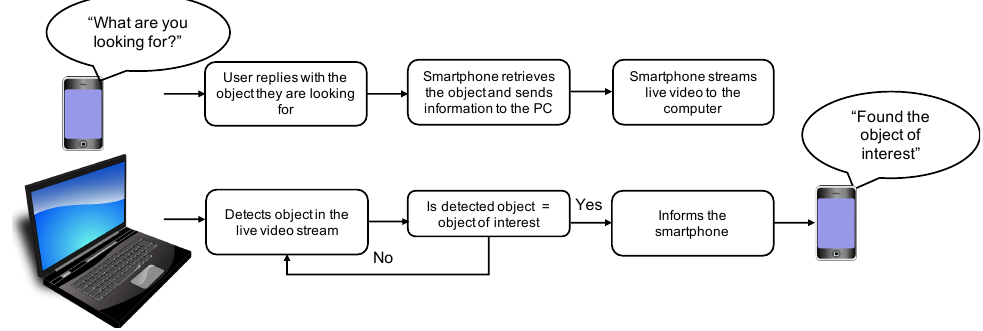
Figure 5. The framework flow of smartphone and computer tasks